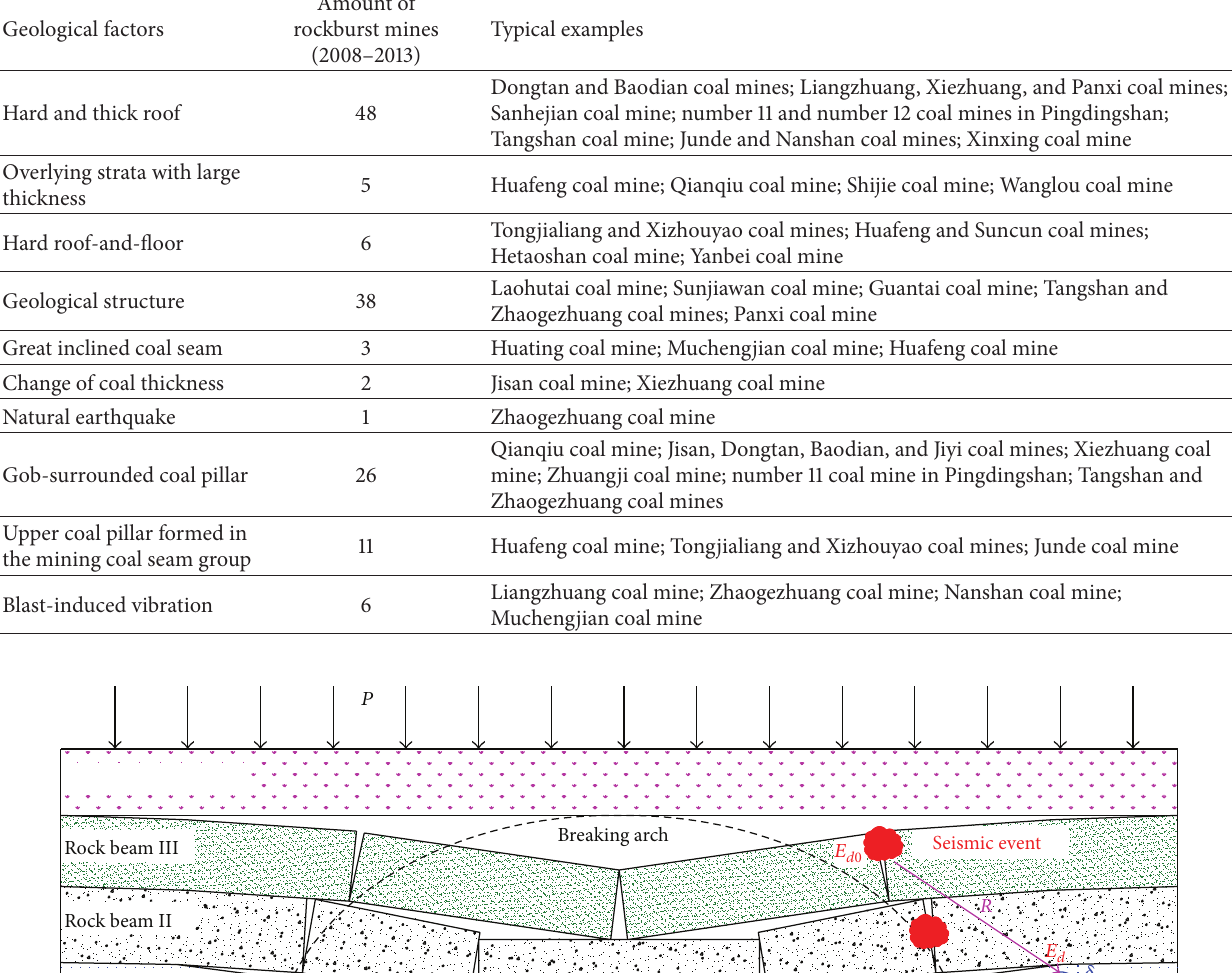
Table 1: Statistics of main factors in rockburst mines [13].